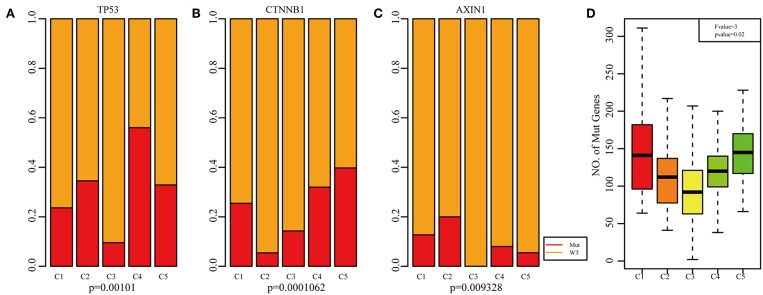
Mutation analysis for the five subtypes of HCC. Red represents the mutation. The mutation ration of TP53 (A), CTNNB1 (B), and AXIN1 (C) in the five HCC subtypes. (D) Frequency of gene mutation across the five HCC subtypes.